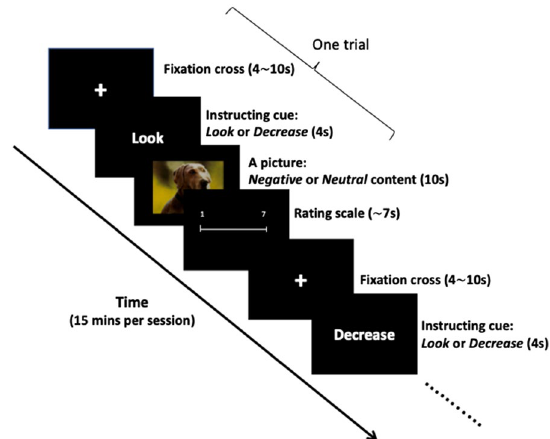
Fig. 1 Schematic of the experimental paradigm. The experiment, in a full factorial, event-related design, consisted of 4 trial types, depending on the valence of the image (Negative/Neutral) and the instruction (Look/Decrease). Following each image, subjects rated how much negative affect they felt when viewing the picture. Trials were separated by a fixation cross lasting 4–10 s. For more details, see Methods and Corbalán et al.